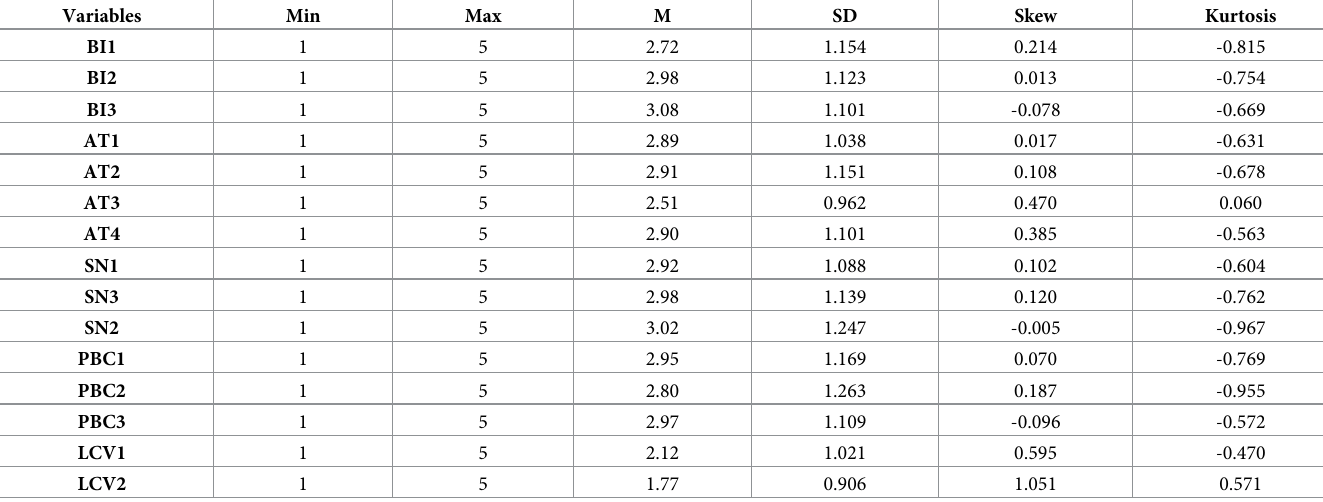
Table 8. Normality assessment of the sample for CFA ( N =